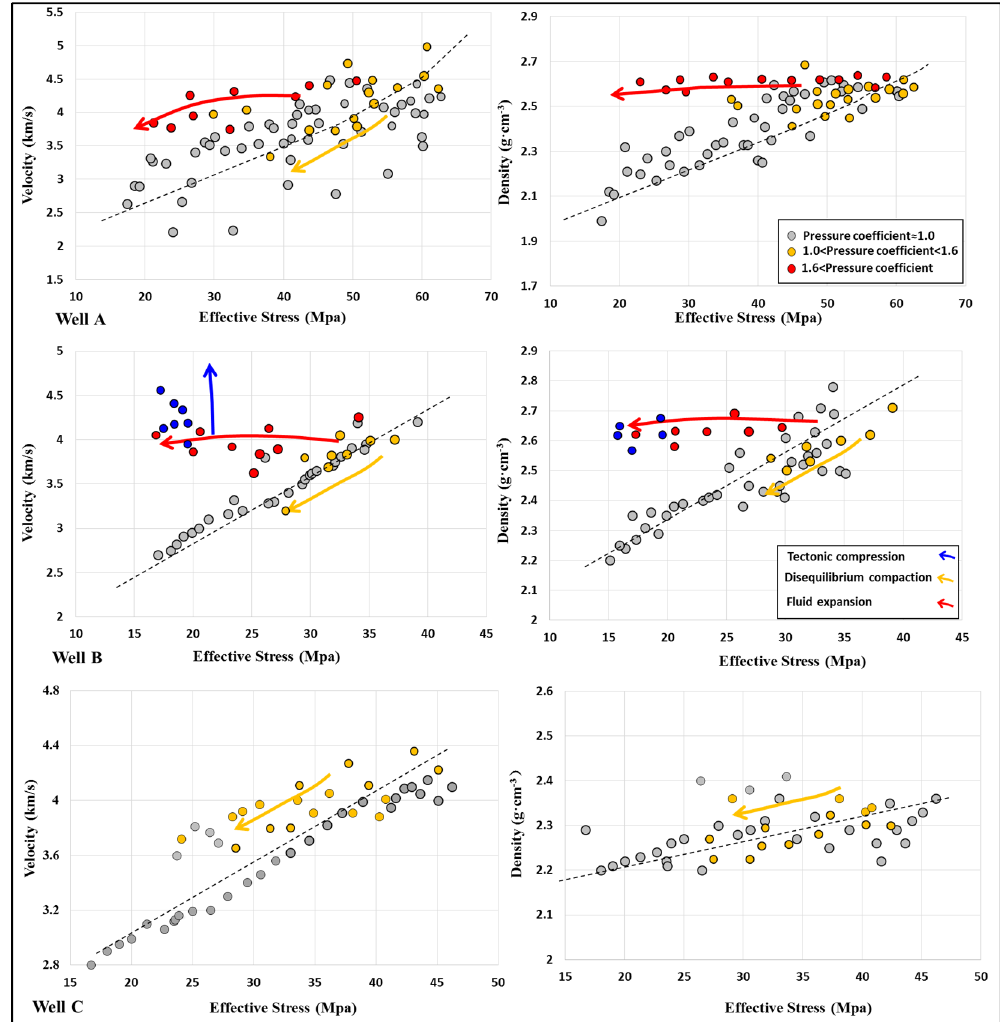
Figure 8. Cross-plot between effective stress and velocity/density.